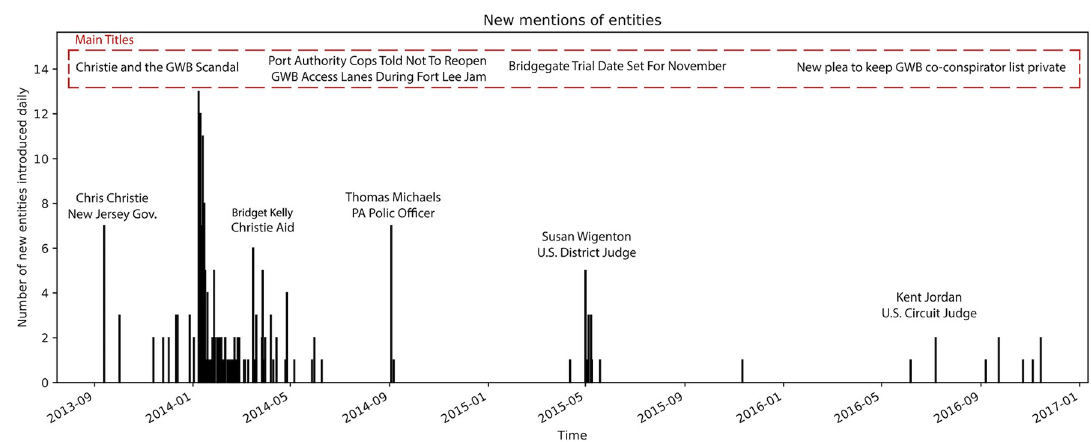
PLOS ONE | https://doi.org/10.1371/journal.pone.0233879 June 16,